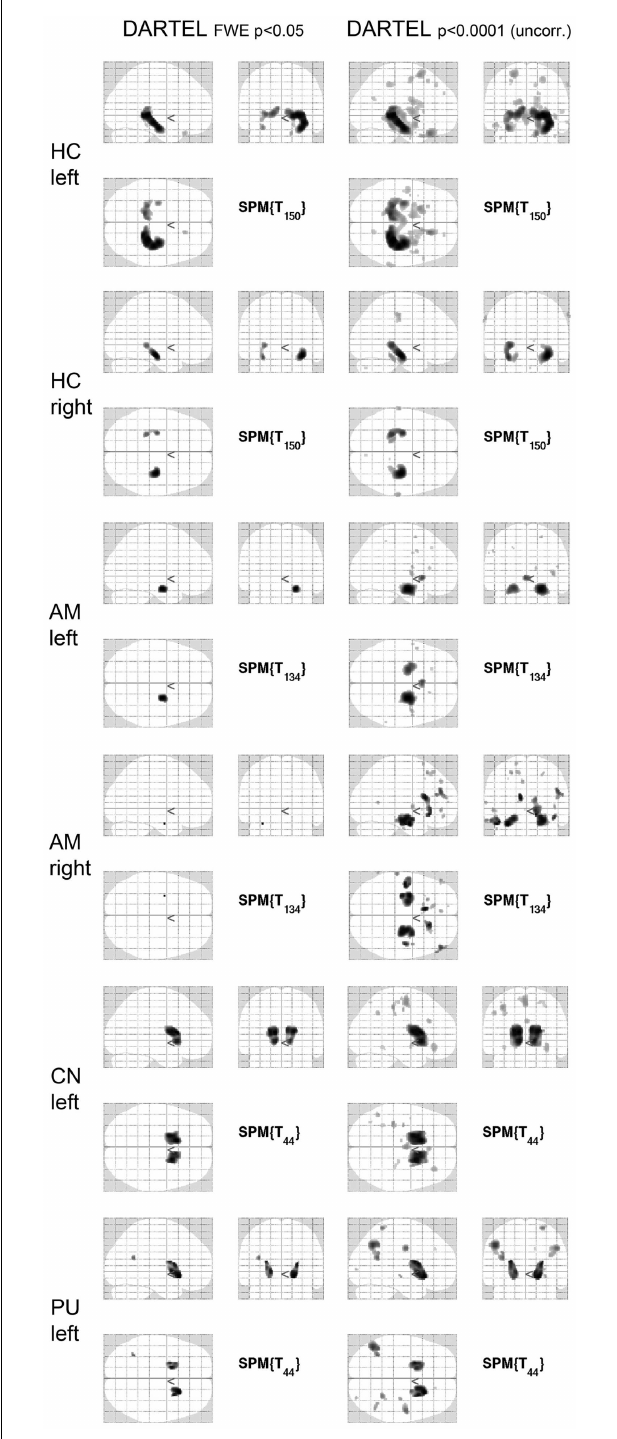
FIGURE 2 | SPM results in glass brain projection . SPM glass brains for different regions and thresholds [ p < 0.05 (FWE corrected) and p < 0.0001 (uncorrected)] are shown. Images are in neurological convention (left in the image is left in the subject). FWE, family-wise error correction; DARTEL, normalization done with DARTEL-toobox; HC, hippocampus; AM, amygdala; CN, caudate nucleus; PU,